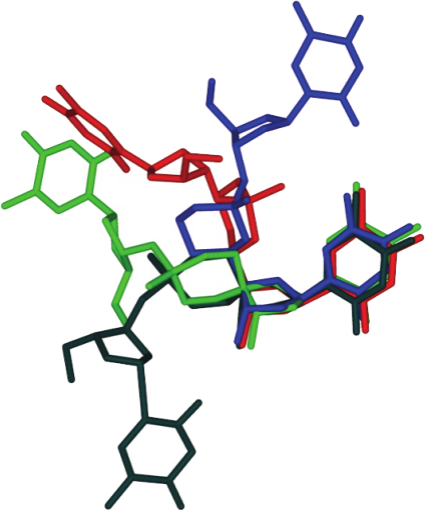
Figure 5: superimposition of minimized structures of α , β -D- CNA ( g − , t ) blue; α , β -D-CNA ( g + , t ) red; α , β , γ -D-CNA ( g − , g − , g − ) green; α , β , γ -D-CNA ( g + , c/g + , g − /a − ) dark green.